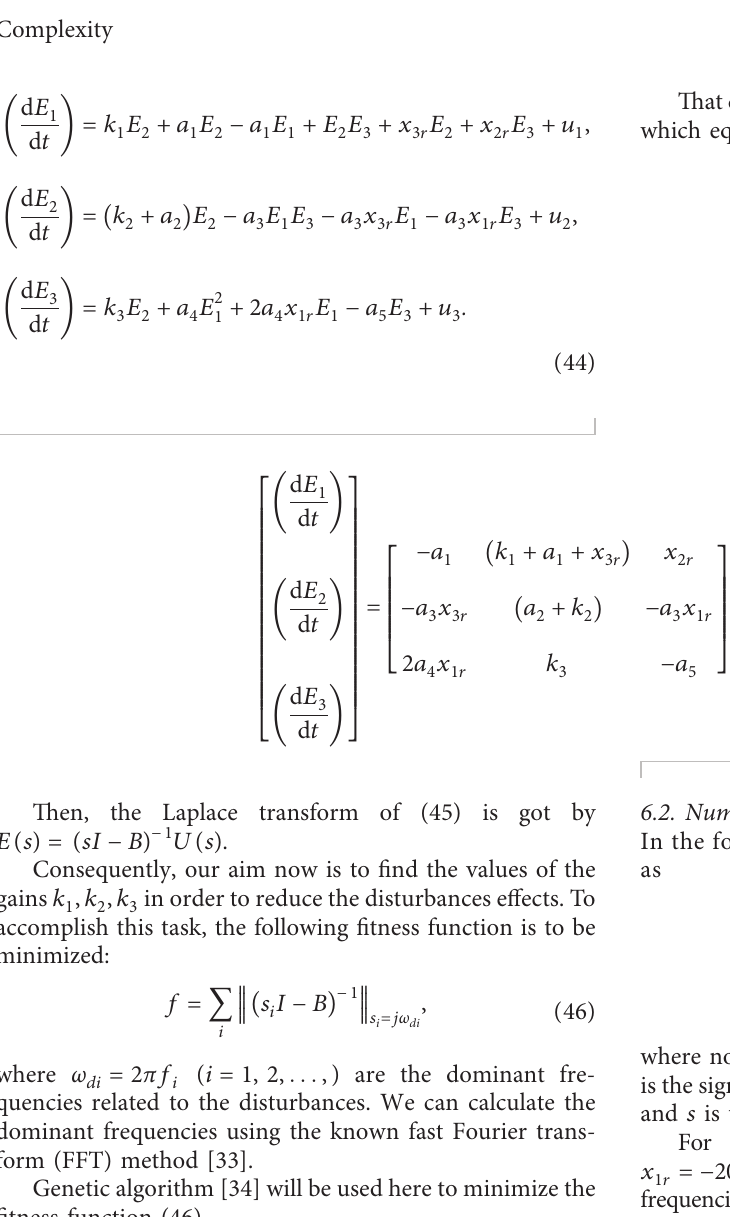
� x � x � 0. Figure 15 shows the 1 r 2 r 3 r � − 5 ; x � 5 ; x � − 1 r 2 r 3 r